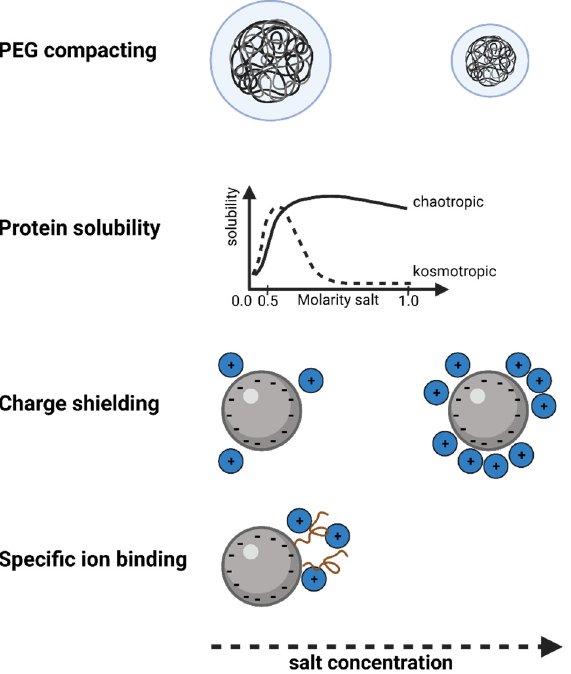
Figure 4. Salt concentration-dependent impact on PEG/salt and salt/protein interactions. Figure prepared using biorender.com.